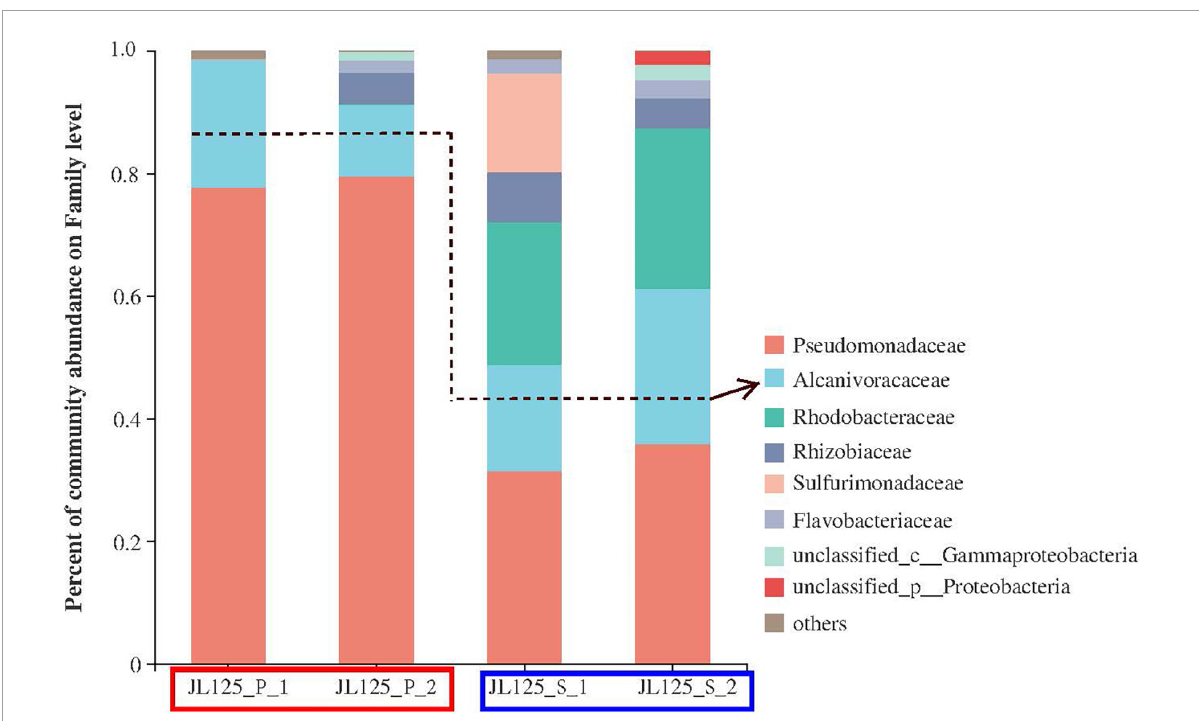
FIGURE2 Relative abundance of the active bacterial community based on the frequency of bacterial 16S rRNA gene in clone libraries at primary (red frame) and secondary (blue frame) enrichment cultures with modified MMJHS medium. The surface biofilms on the in situ sample were inoculated to the modified MMJHS medium with hydrothermal massive sulfide powder as energy source. In order to exclude the influence of relic nucleic acid molecules in the initial inoculum and obtain a stable bacterial community, the primary cultures need to be inoculated into a new